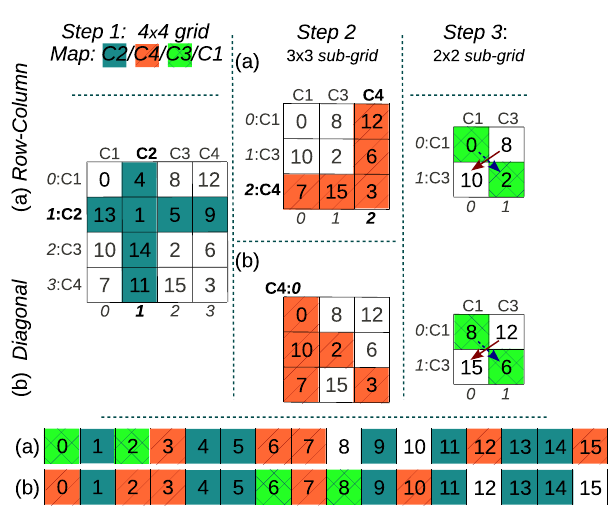
Figure 3. Three steps of the channels-to-slots mapping: (a) Row- Column, (b)